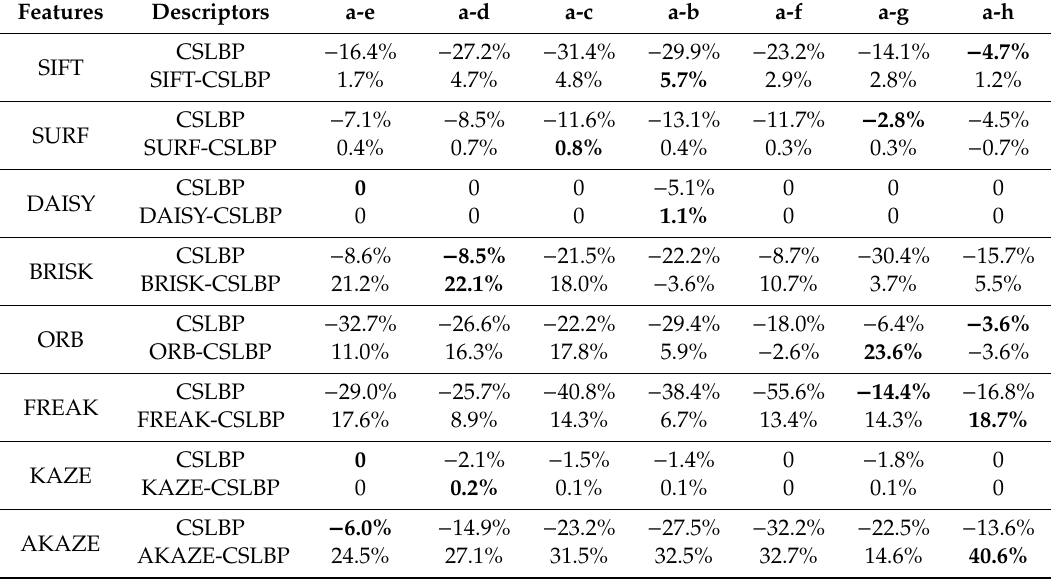
Table 8. The improved values of precision for the CSLBP and the combined descriptors compared to the original descriptors of Gra ffi ti